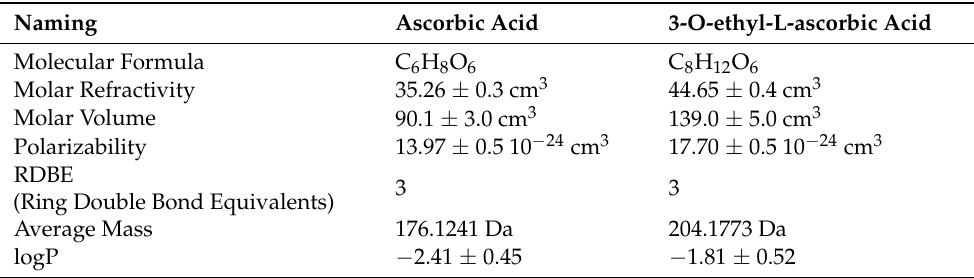
Table 2. Comparison of selected physicochemical properties of ascorbic acid and 3-O-ethyl-l- ascorbic